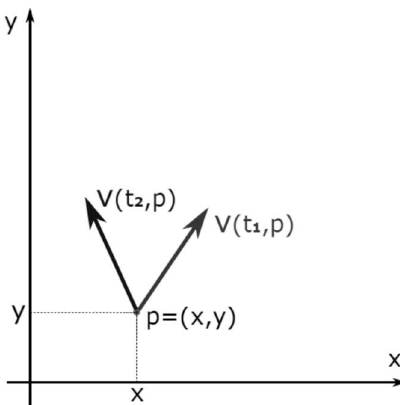
Figure 2. Eulerian approach – at the given point p = ( x, y ) of the fluid domain, vectors of velocity in two distinct moments in time are shown: t 1 and t